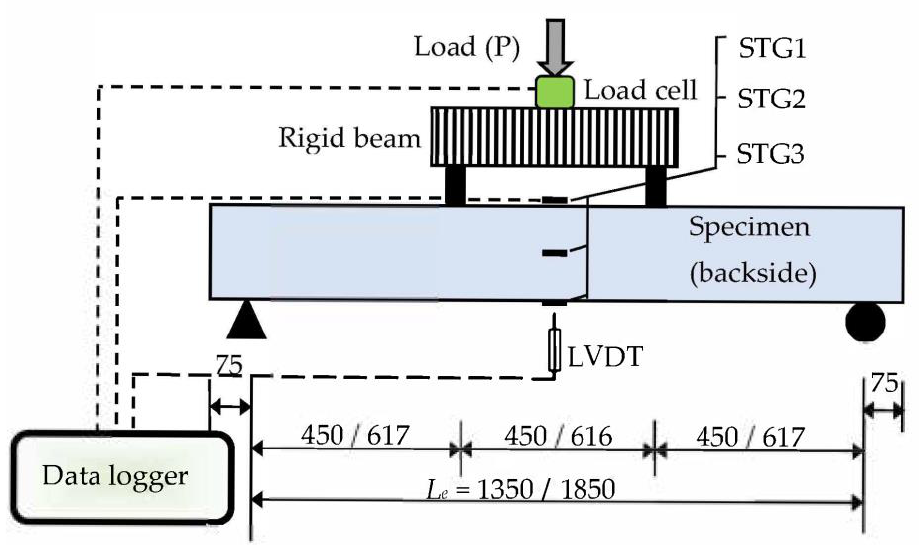
Figure 4. Schematic test setup for short/long specimens (all dimensions in mm).